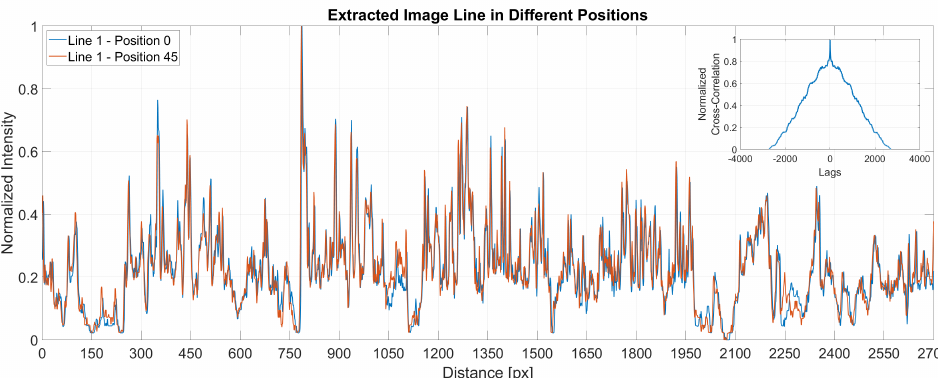
Figure 7. Cross − correlation between samples.